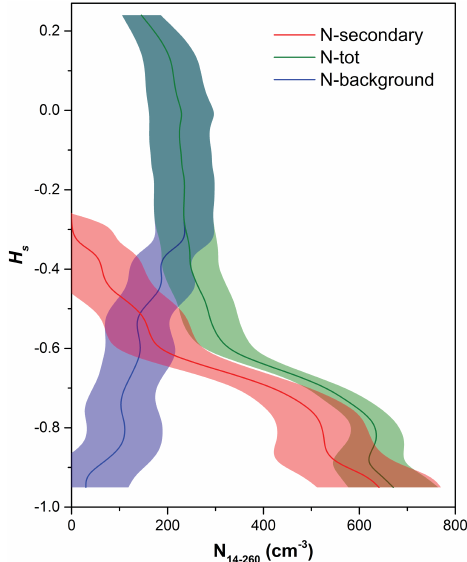
Figure 9. Springtime statistical mean profiles of N 14 − 260 (green line) apportioned along height for the contribution of background N 14 − 260 aerosol (blue line) and of secondary locally formed N 14 − 260 aerosol (red line) for the decoupled negative gradient pro- files (DNG)